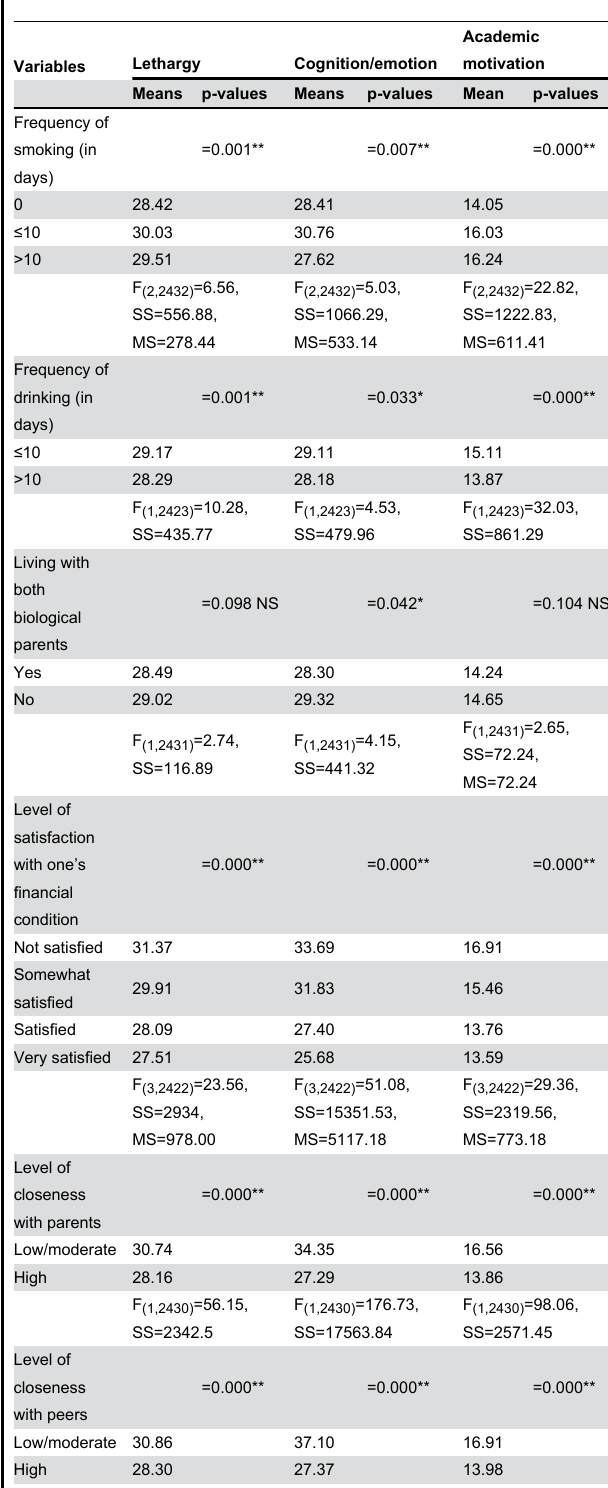
Table 2. Means and standard deviations for depressive symptoms scale scores by social and demographic characteristics.